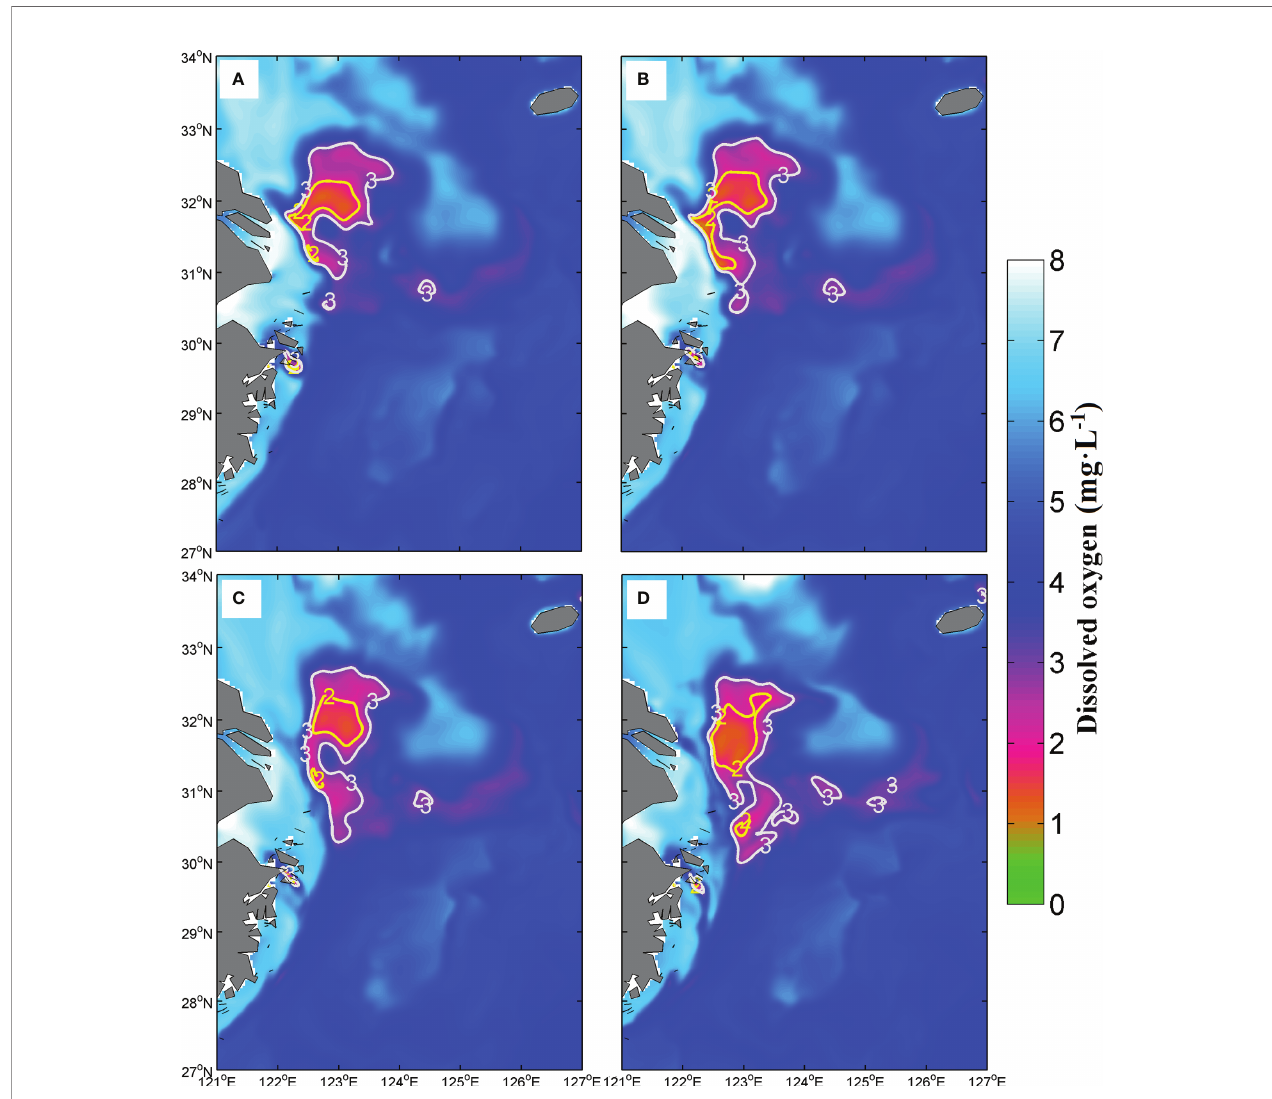
FIGURE 9 | The modeled bottom DO concentration distributions on August (A) 22, (B) 25, (C) 26, and (D) 28, 2020. Yellow and white contour lines indicate DO concentrations of 2 and 3 mg·L − 1 ,